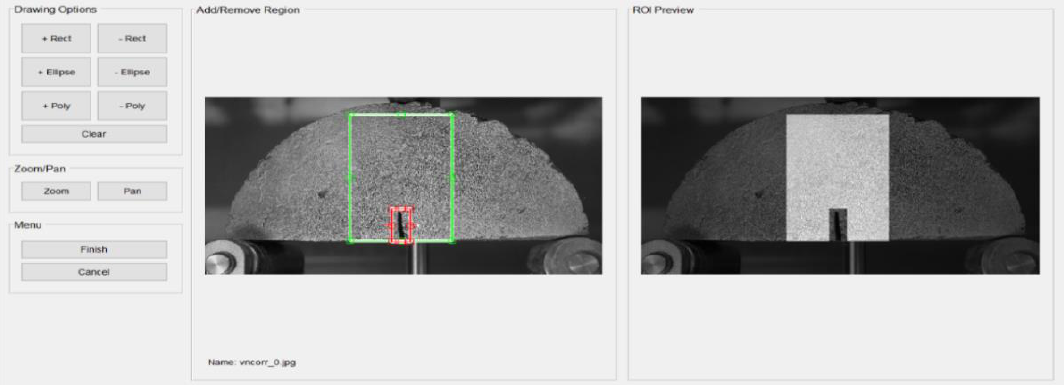
Figure 8. Set the ROI of the image.